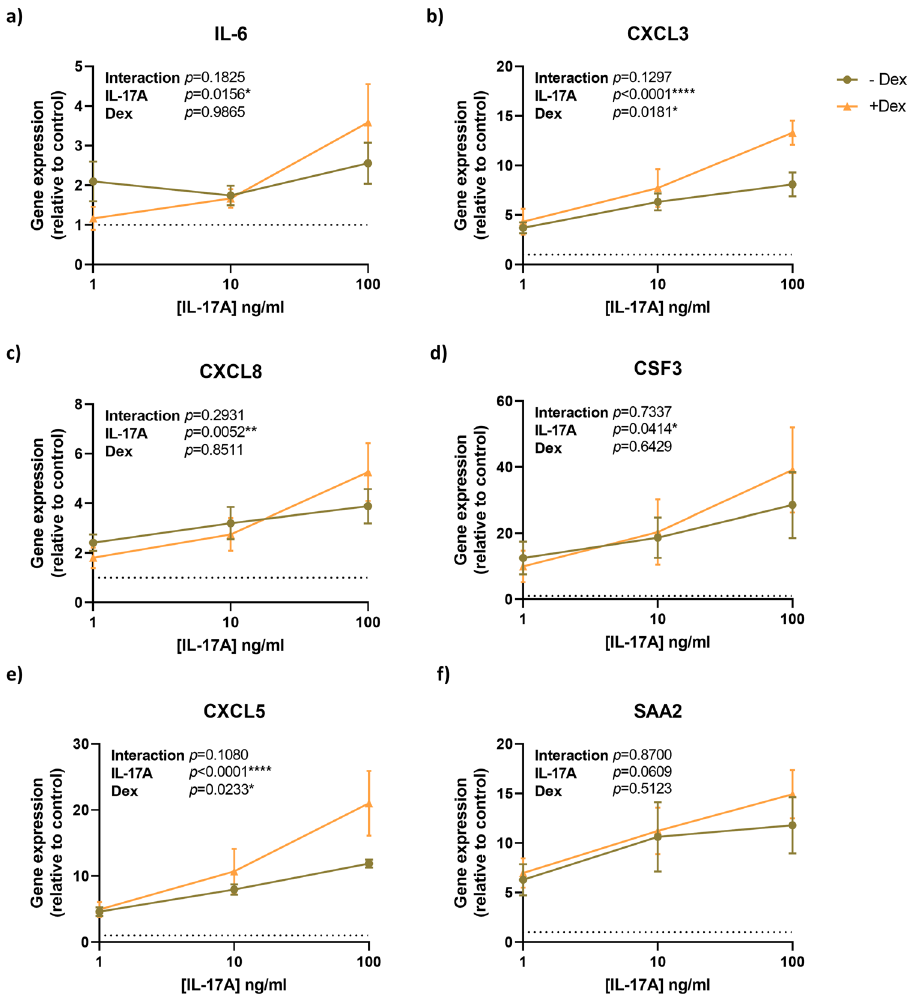
Figure 1. IL-17A stimulates IL-17 signature genes in basal airway epithelial cells (hAECs). hAECs were cultured submerged and exposed to IL-17A (10 ng/ml) with or without dexamethasone (Dex; 10 nM) for 24 h. Expression of ( a ) IL-6 , ( b ) CXCL3 , ( c ) CXCL8 , ( d ) CSF3 , ( e ) CXCL5 , ( f ) SAA2 were analyzed by real-time qPCR. Data represent means ± SEM. N = 4 donors, [IL-17A] = IL-17A concentration. Statistical analyses were performed with two-way ANOVA, *p < 0.05, **p < 0.01, ****p <